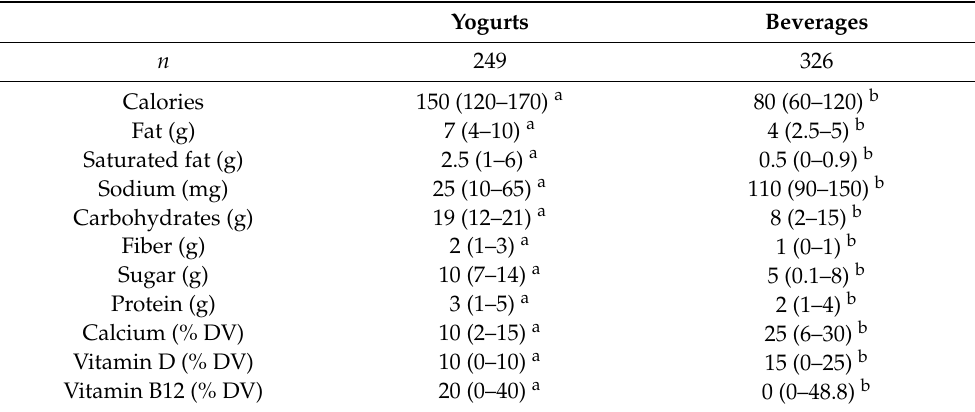
Table 4. Medians (Q1–Q3) for calories and nutrients in non-dairy yogurt alternatives versus non-dairy, plant-based multi-serve beverages/serving.